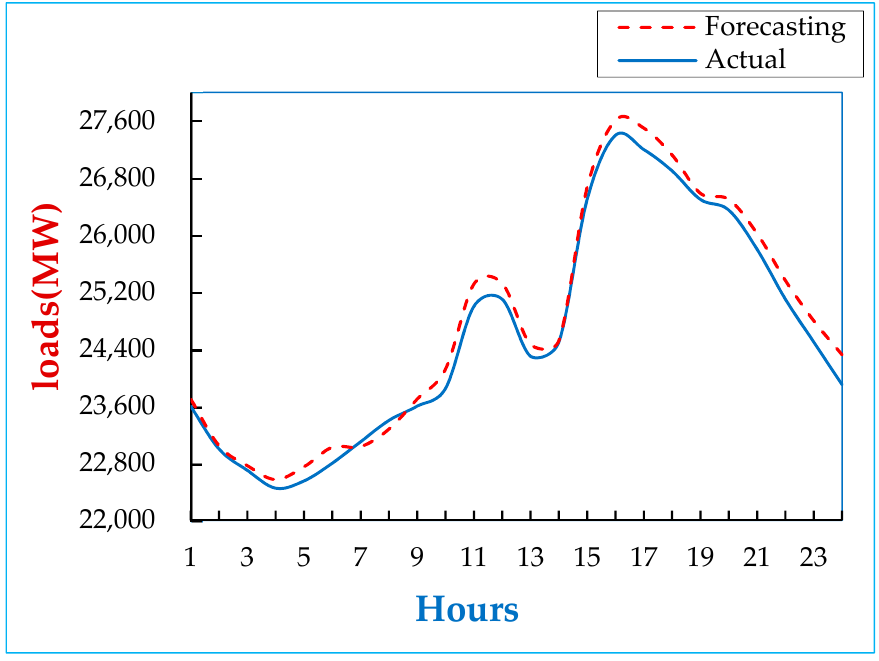
Figure 4. Load forecasting results for working days (Monday, 7 September 2020).